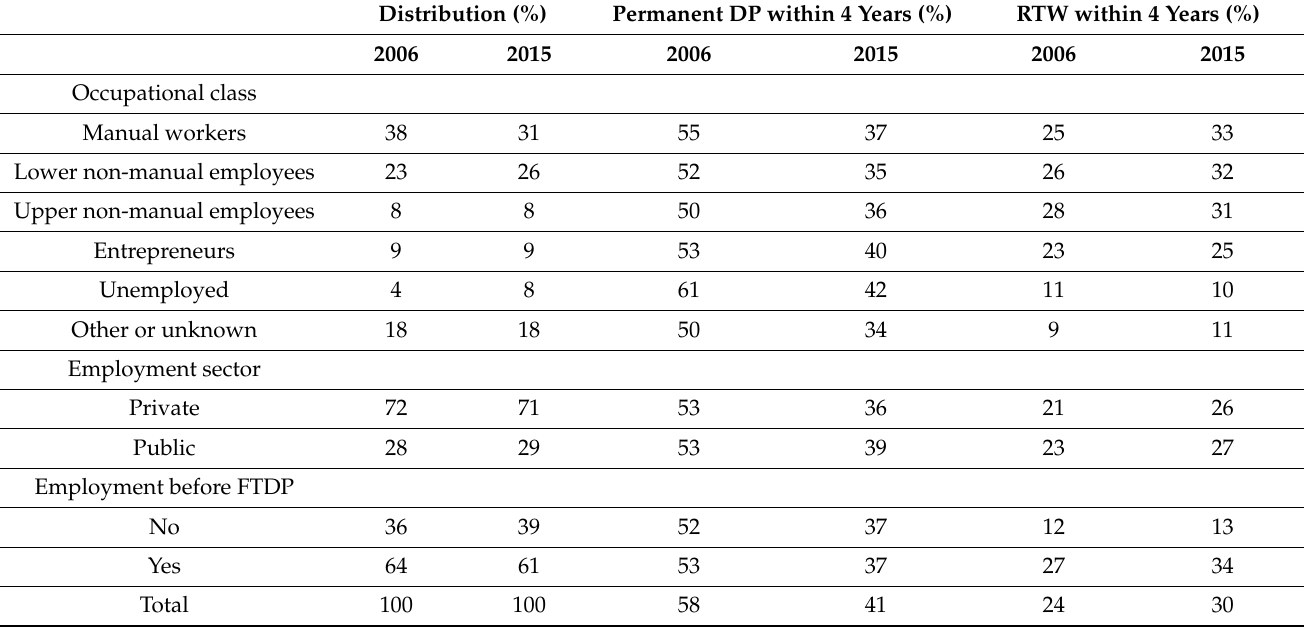
Table 2. Distributions of the occupational confounding variables and the probability of transferring to permanent disability pension (DP) and returning to work (RTW) by these variables in 2006 and